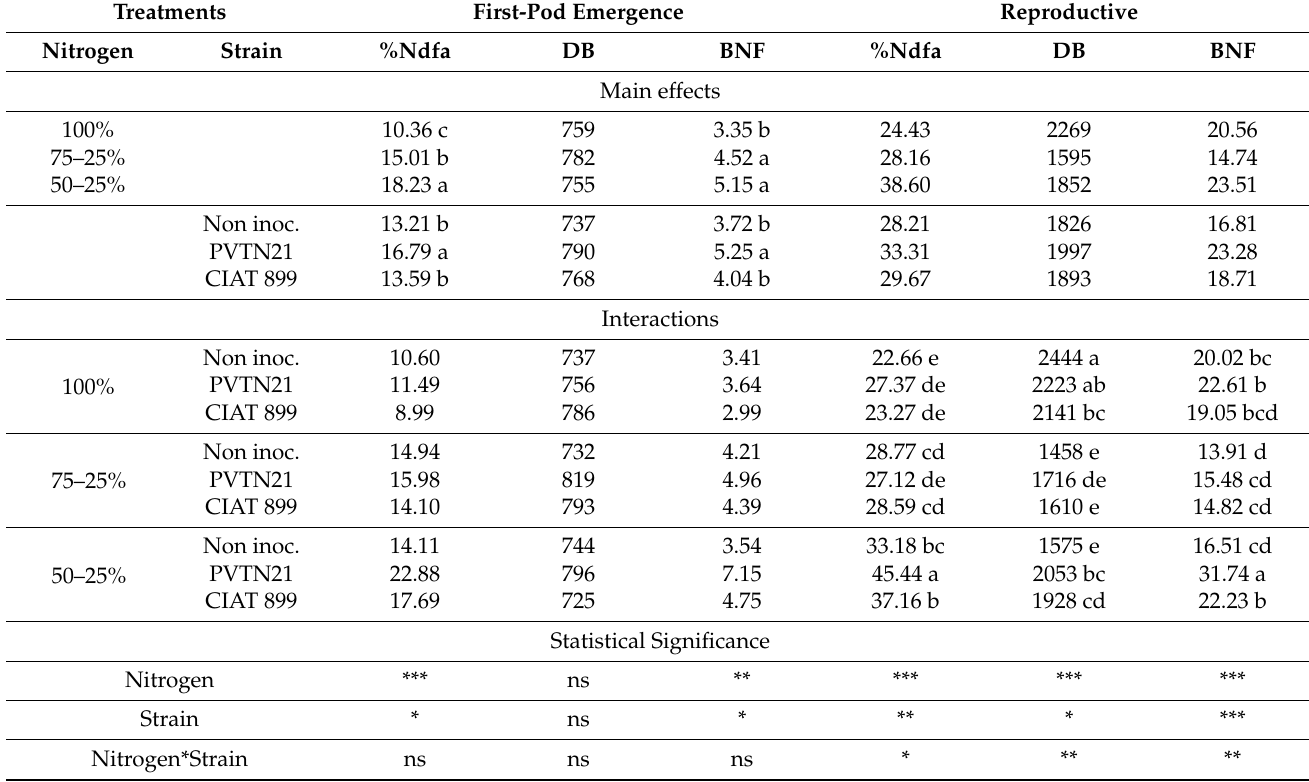
Table 3. The proportion of N derived from air (%Ndfa), dry biomass (DB kg/ha) and total amount of fixed N (BNF kg/ha) in the common-bean ( Phaseolus vulgaris L.) shoots treated with varying quantities of inorganic-N (100%, 75–25, or 50–25%), and/or inoculation with rhizobia strains (PVTN21 or CIAT899), at the different (later) growth stages of first-pod emergence and reproductive (pod